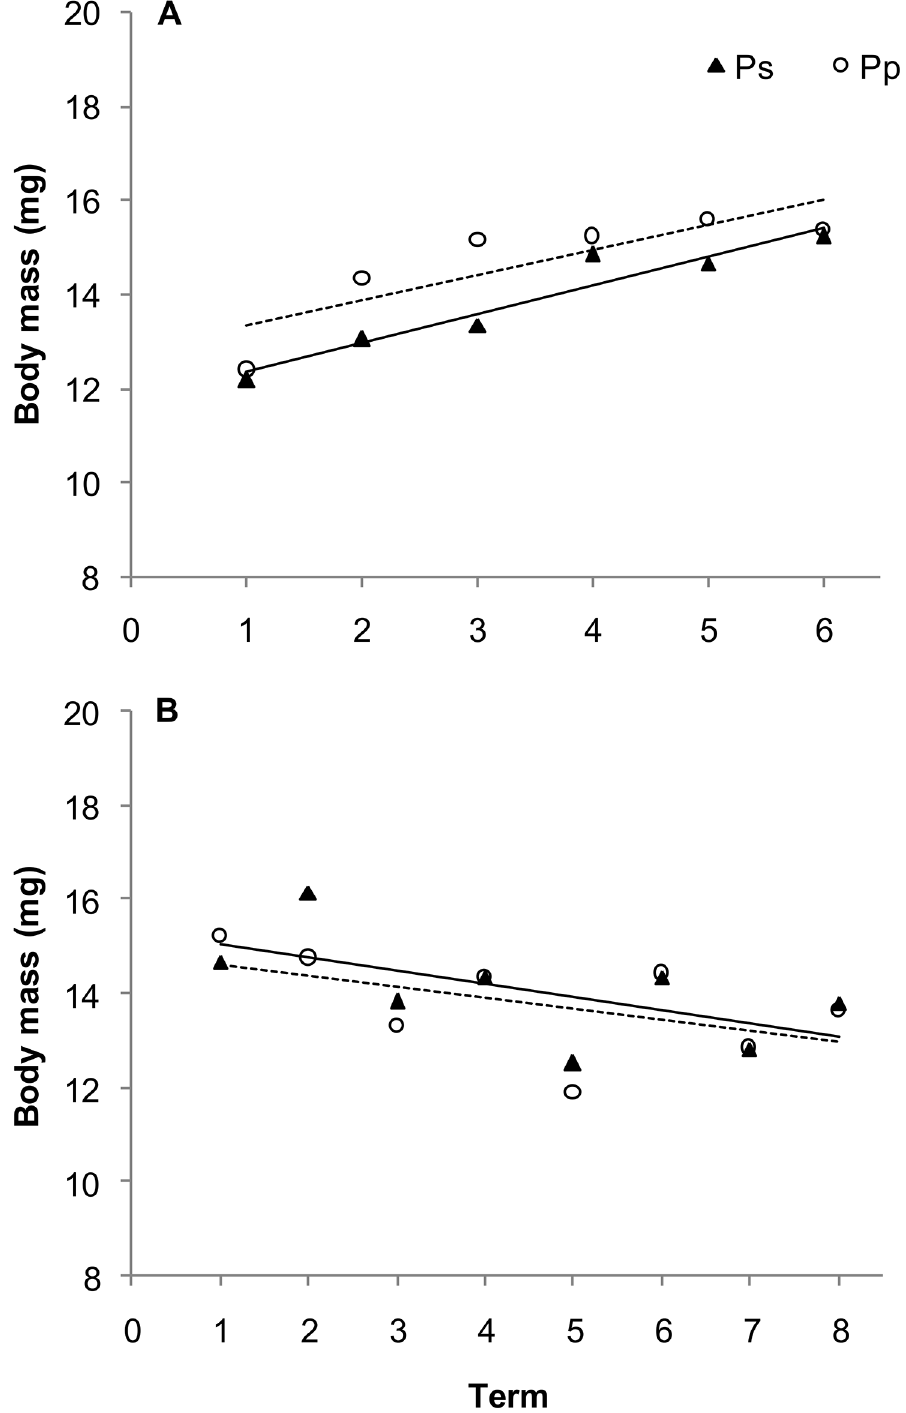
Fig 2. Body mass of current-year (A) and 1-year-old (B) Gonioctena quinquepunctata beetles on Prunus padus (Pp) and Prunus serotina (Ps) shrubs over time. Numbers 1 – 6 and 1 – 8 indicate successive dates of insect collection (see Materials and Methods). One-way ANOVA was used to determine the effect of term (length of the sampling period) on the body mass of beetles on Ps (current-year, R 2 = 0.0999, P < 0.0001; 1-year-old, R 2 = 0.0894, P < 0.0001) and on Pp (current-year, R 2 = 0.0878, P <